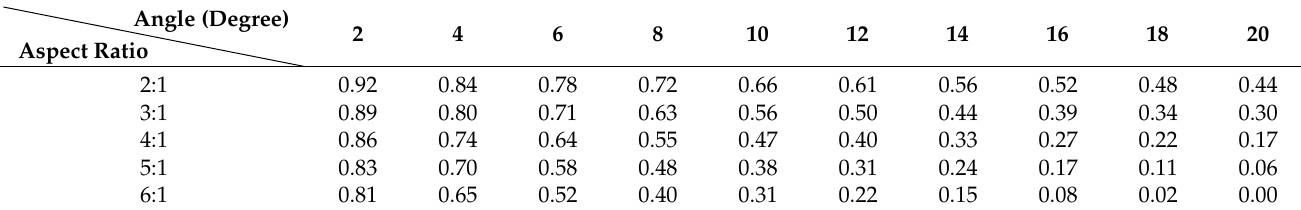
Table 1. IoUs of frames with different aspect ratios under various